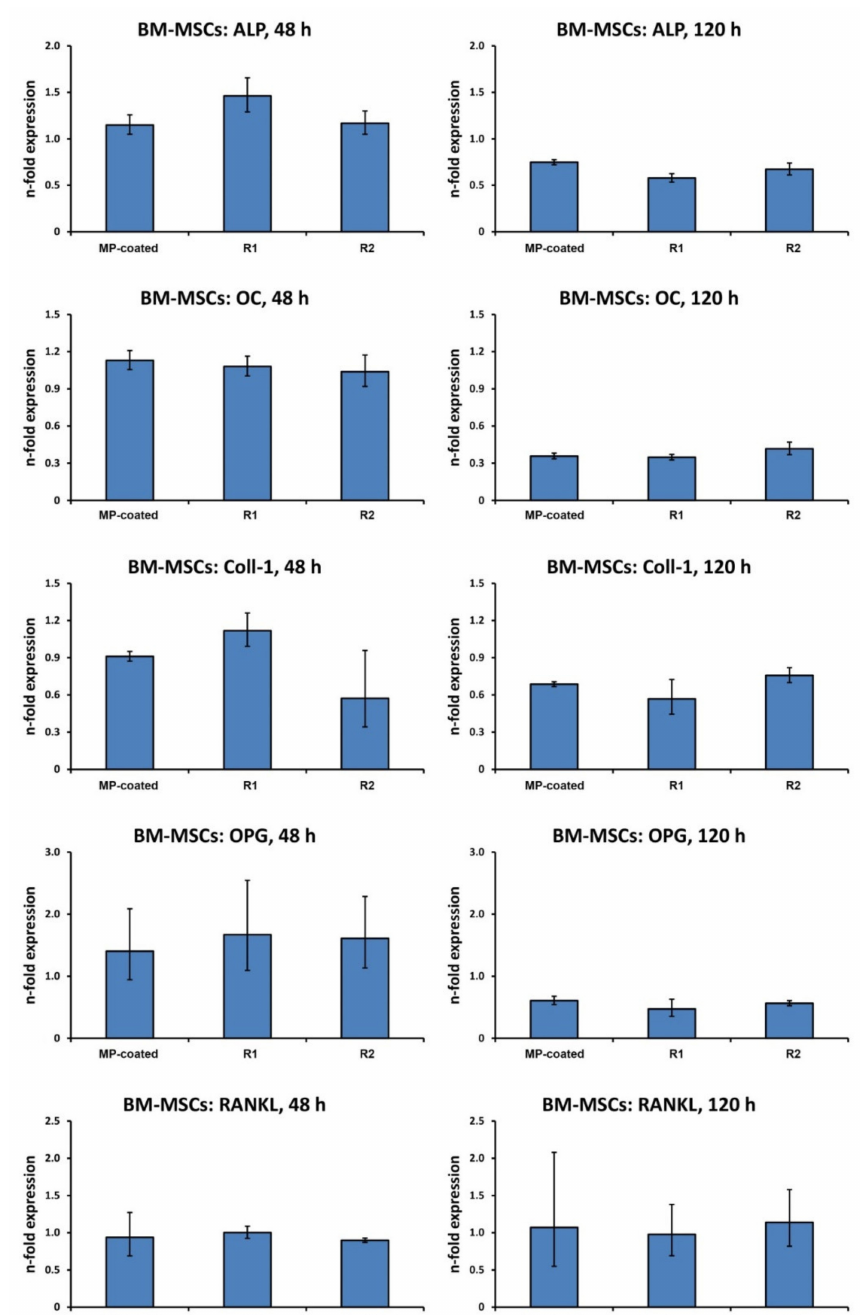
Figure 5. Expression of genes related to osteogenesis and bone turnover in BM-MSCs grown on titanium surfaces. BM-MSCs were cultured on multi-phosphonate (MP)-coated, sand-blasted, and acid-etched reference surfaces (R1, R2) and tissue culture plastic (TCP) for 48 and 120 h, and the expression of ALP, OC, Col1, OPG, and RANKL was assessed by quantitative real-time PCR. Y-axis represents n-fold expression related to BM-MSCs on TCP determined using the 2 − ∆∆ Ct method, using GAPDH as a housekeeping gene. Data are shown as the mean ± S.E.M of four experiments that were conducted